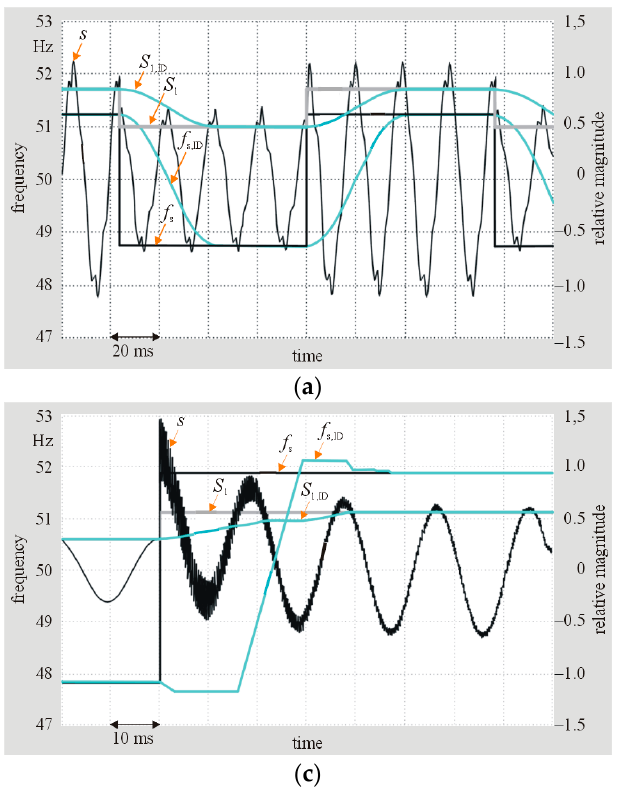
Figure 7. Response of the IS to a step-change in the measured signal frequency in the range of ( a ) 50 ± 0.7 Hz and ( b ) 50 ± 2.3 Hz.